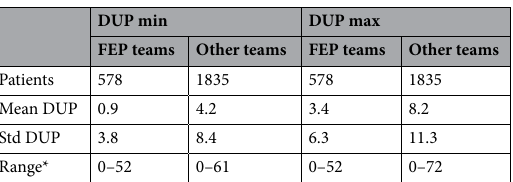
Table 3. Comparison of estimated DUP characteristics for FEP teams vs. other teams. *We considered DUP values of − 1 as 0-year durations (i.e. 1-year error